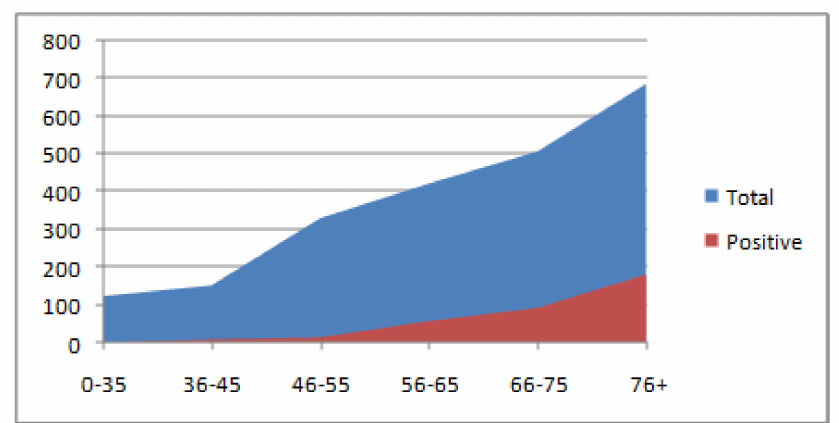
Figure 2. The proportion of positive results of the hs-cTn I test relative to the total number of requests. A distribution according to the six age groups.